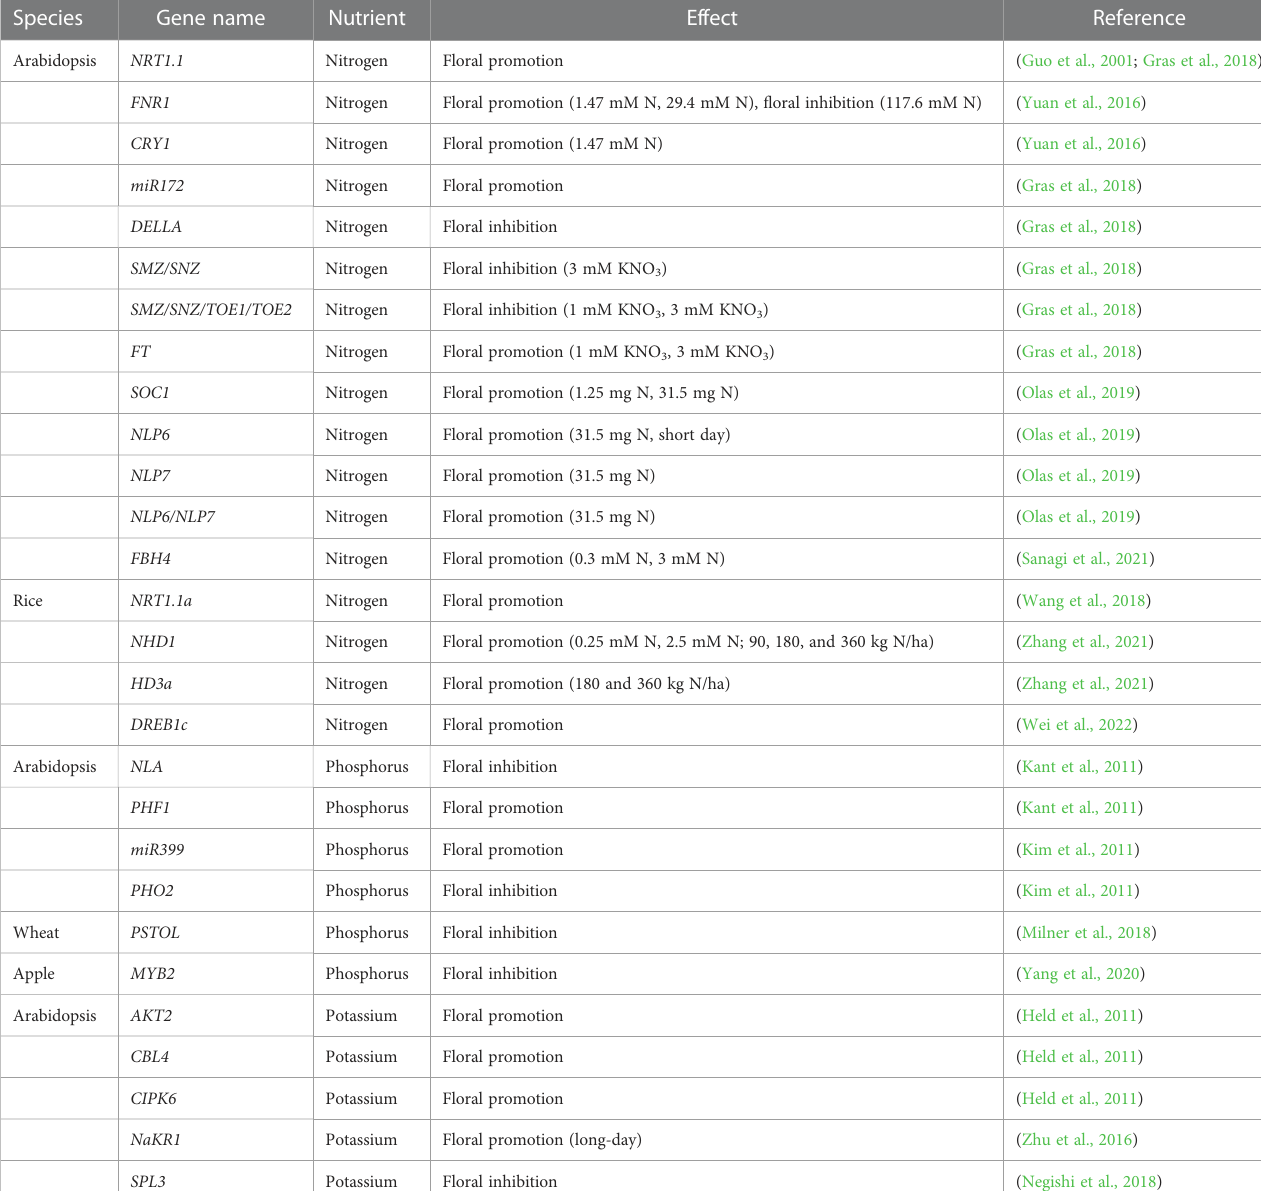
TABLE 1 Genes involved in nutrient-mediated modulation of fl owering time.